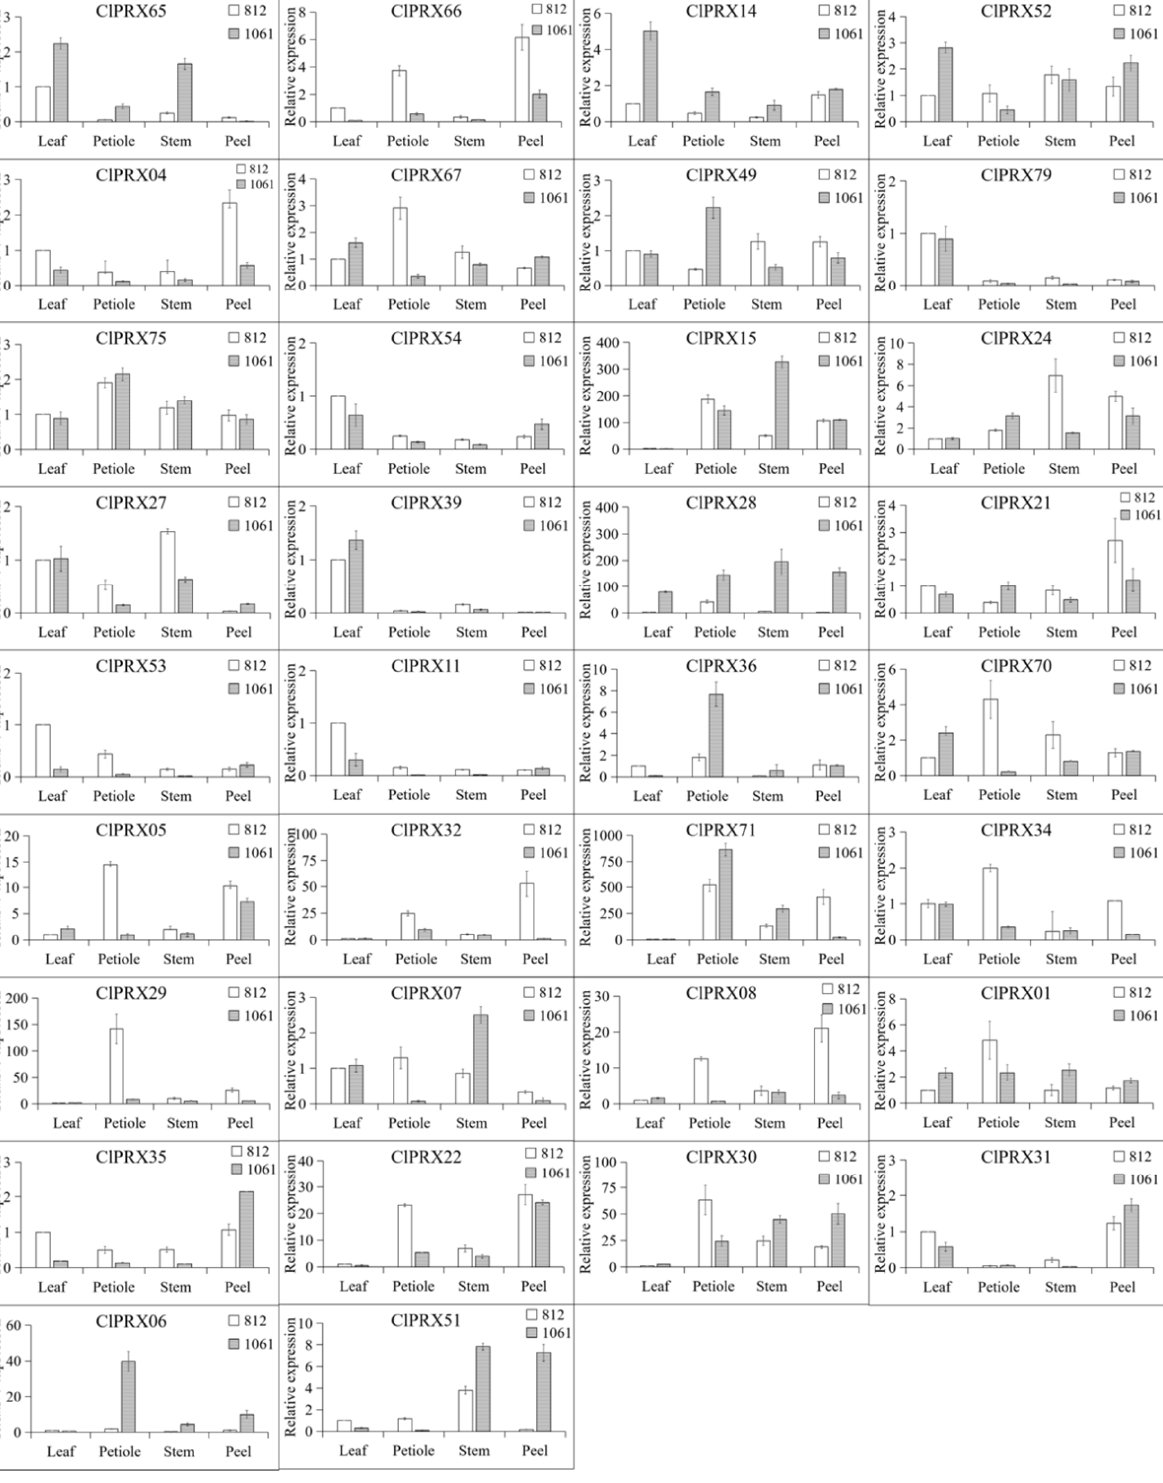
Figure 11. Expression levels of ClPRXs in different tissues. The values represent the means ± SDs, and different bars indicate significant differences ( p < 0.05) of genes’ expression level. Six ClPRXs ( ClPRX54 , ClPRX28 , ClPRX35 , ClPRX30 , ClPRX06 , and ClPRX51 ) had sig-